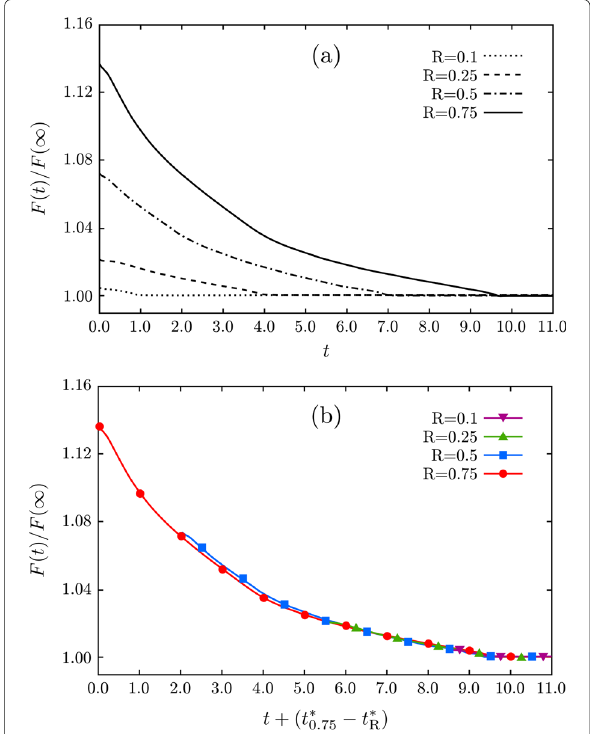
Fig. 4 Energy decreasing during the evolution of pit geometries. a F ( t ) normalized by the energy of the flat (001) surface obtained as final stage of the evolution. Energy decays obtained from the simulations having different R for the initial profile, namely, from R = 0.1 to R = 0.75, are shown. Time is expressed in arbitrary units. b Curves as , i.e., the time at which in panel a shifted in order to match t ∗ R